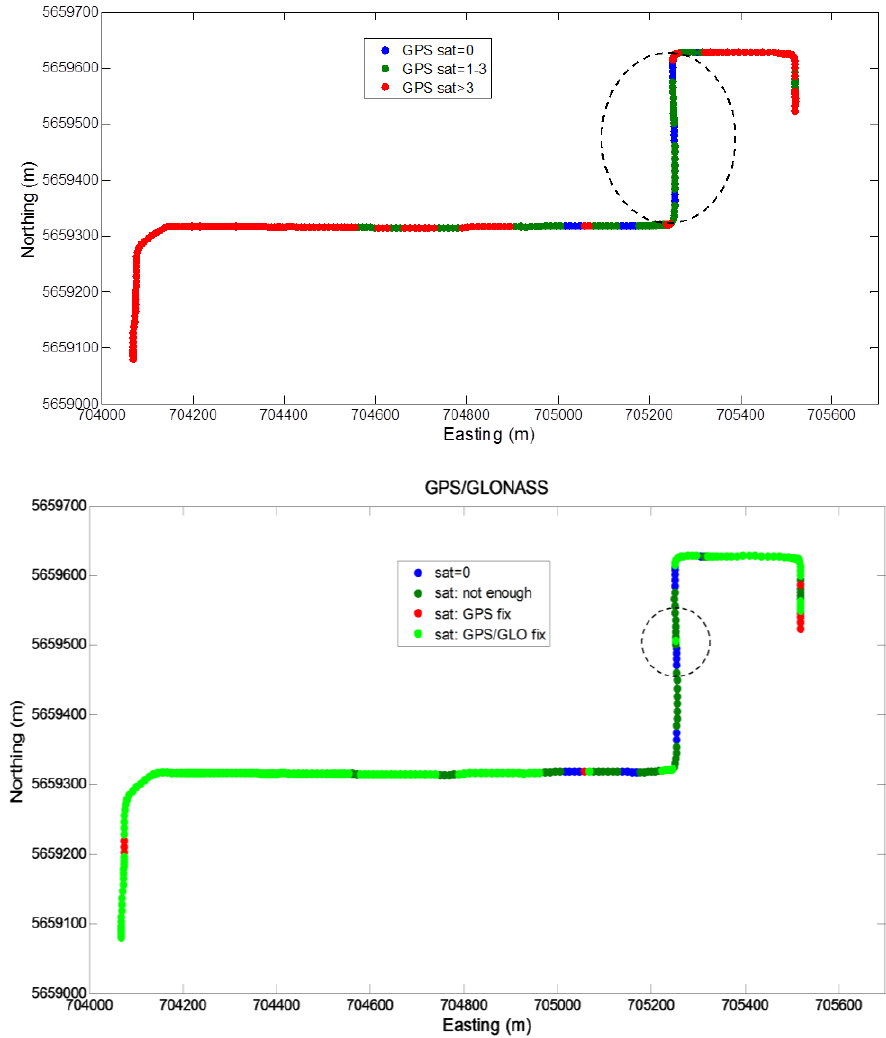
Figure 7. GNSS visibility on the Segment 1